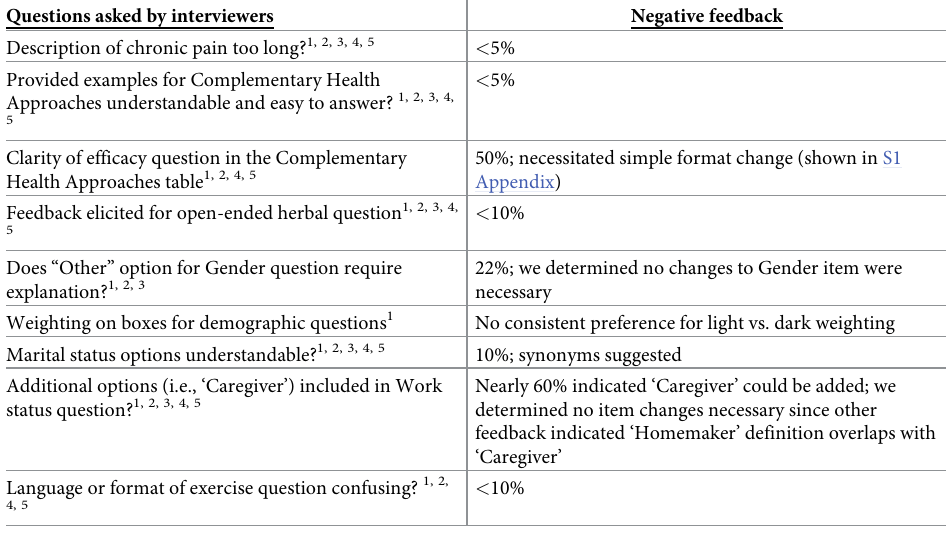
Table 1. Participant feedback regarding the effectiveness of the Complementary Health Approaches for Pain Sur- vey (CHAPS) in a subgroup of patients seeking conventional care for pain management using questions to assess negative feedback regarding attractiveness, comprehension, acceptability, self-involvement, and persuasion of measurement items (N =